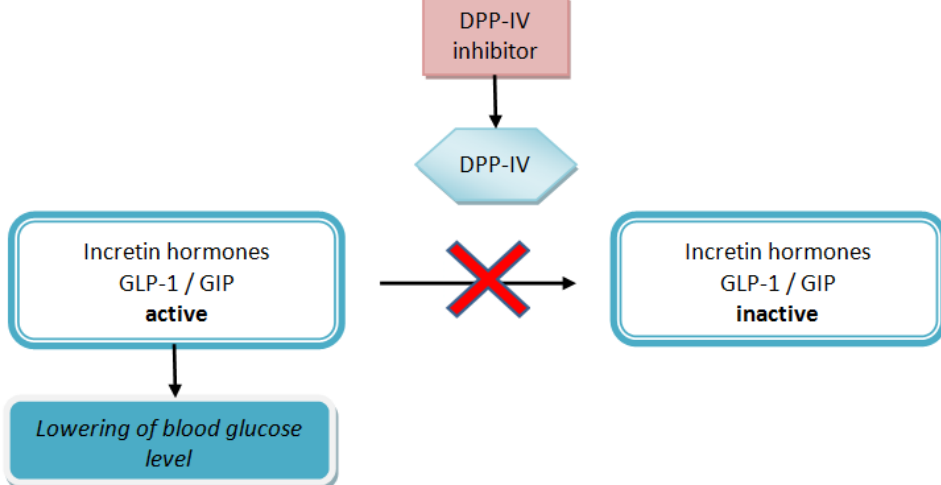
Figure 1. The scheme of the activity of the dipeptidyl peptidase IV (DPP-IV) inhibitor; GLP-1: glucagon-like peptide-1; GIP: glucose-dependent insulinotropic peptide.